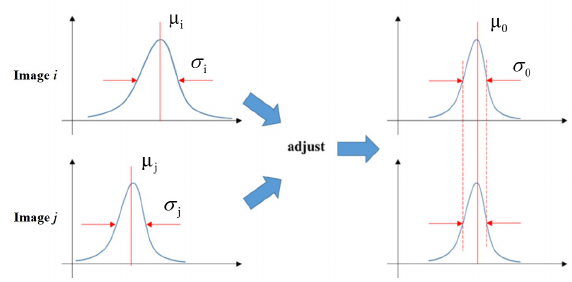
Figure 8. The illustration of intensity